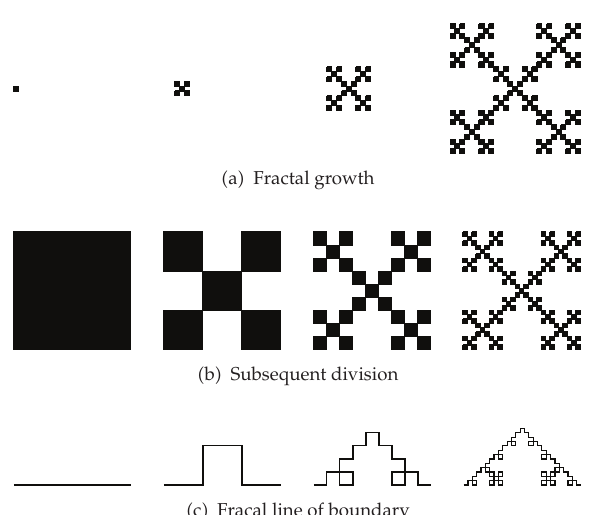
Figure 1: A growing fractal and its self-similar boundary line (cid:3) the first four steps are obtained by Vicsek (cid:5) 31 (cid:6) , Longley et al. (cid:5) 23 (cid:6) , Frankhauser, (cid:5) 33 (cid:6)(cid:4) .